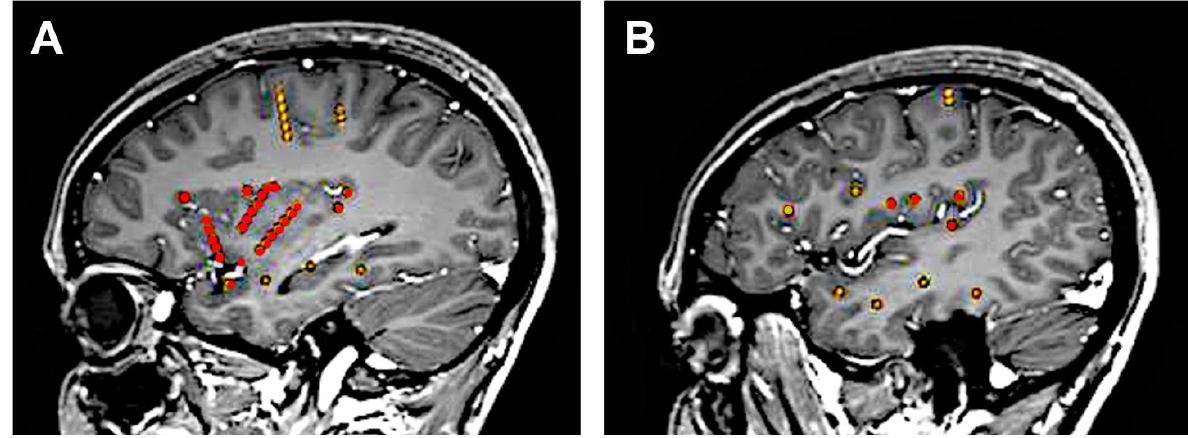
Figure 2. Typical SEEG investigation of the insula . This 25-year-old female had seizures that clinically strongly suggested insulo-opercular involvement without clear scalp EEG lateralization. Bilateral asymmetric SEEG implantation was performed but only for the left side, which is shown. The insulo-opercular region was covered by ( A ) three oblique electrodes exploring the anterior and posterior short gyri and the anterior long gyrus of the insula, as well as by ( B ) several lateral orthogonal electrodes that reached the insula through the supra-sylvian and temporal opercula. Additional electrodes also explored the temporal region and the motor cortex. Insular electrodes are depicted in red, while other electrodes are depicted in yellow. EEG: electroencephalography; SEEG: stereo-electroencephalography.